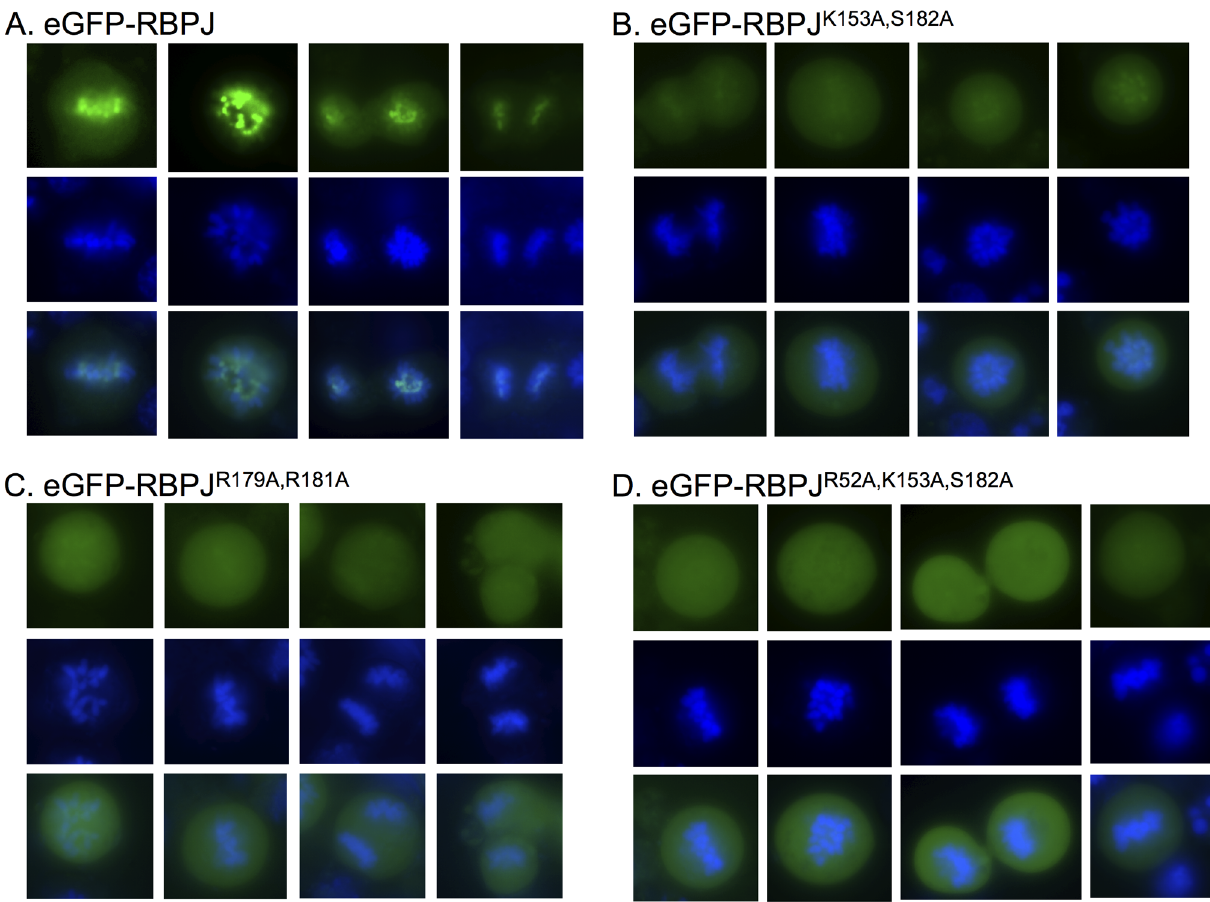
Figure 1. RBPJ associates with mitotic chromatin through direct DNA contacts. Fluorescence microscopy imaging of live F9 cells transiently expressing eGFP-tagged RBPJ or RBPJ derivatives harboring mutations in residues predicted to contact DNA (green). Chromatin was counterstained with Hoechst 33342 (blue). (A) F9 cells expressing eGFP-RBPJ. (B) F9 cells expressing eGFP-RBPJ K153A,S182A . (C) F9 cells expressing eGFP-RBPJ R179A,R181A . (D) F9 cells expressing eGFP-RBPJ R52A,K153A,S182A . R52A, K153 and S182 are conserved residues predicted to contact DNA bases. R179 and R181 are conserved residues predicted to contact the phosphodiester backbone.